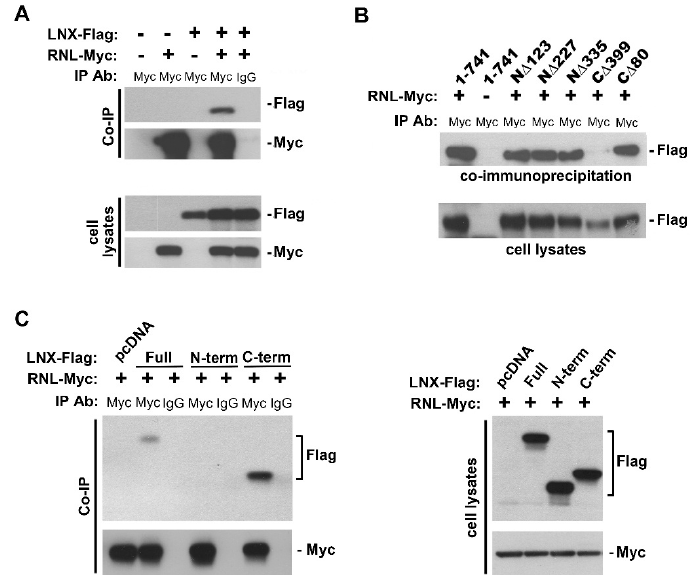
Figure 2. RNase-L interacts with LNX. ( A ) 293T cells were transfected with pCMV3-RNL-myc, pcDNA3-hLNX-Flag, or the respective empty vectors using Lipofectamine 2000 (Invitrogen). Cell lysates were immunoprecipitated (IP) using anti-Myc-tag or IgG control antibodies bound to protein A/G agarose beads. Bound protein complexes were detected by Western blot analysis using the antibodies as indicated; ( B ) RNase-L and ( C ) LNX deletions were used in IP studies as in ( A ) to determine their respective interaction domains [43,127]. RNase-L deletions were subcloned from the pGEX4T3 plasmid (kindly provided by R.H. Silverman) into the eukaryotic expression plasmid pCMV3B using the BamHI and XhoI restriction sites.